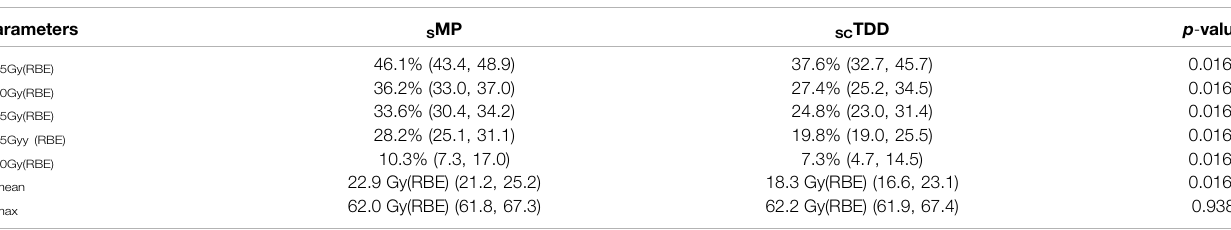
TABLE 2 | Comparison of dosimetric characteristics for tongue between the S MP and SC TDD.